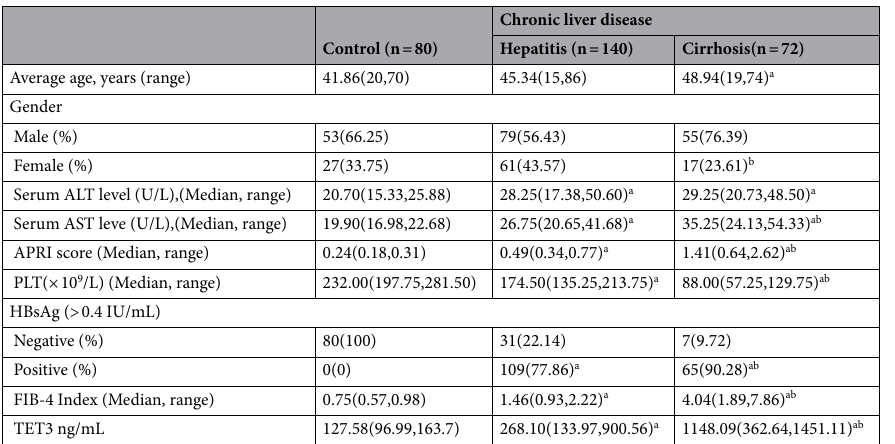
Table 1. Baseline Characteristics of the 212 patients with chronic liver disease. a P < 0.05 versus control; b P < 0.05 versus hepatitis. Abbreviations:ALT, alanine aminotransferase; AST, aspartate aminotransferase; FIB- 4, fibrosis-4; APRI, AST to platelet ratio Index; PLT, platelet count; HBsAg, Hepatitis B surface antigen; TET3, Ten-eleven translocation protein